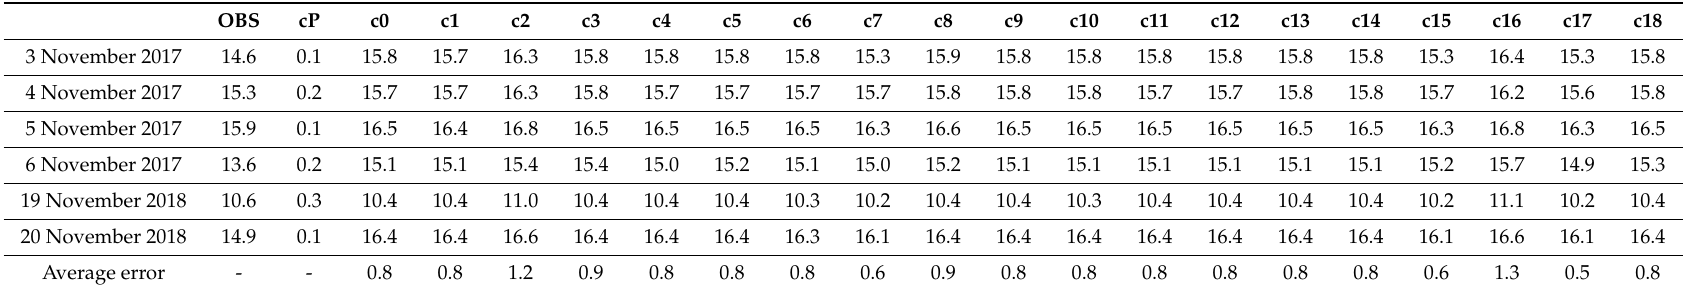
Table 3. Daily mean two-meter temperature (T2m) values ( ◦ C) at the CIRA site for the days considered, for observational and model data (all configurations). Average cumulative errors with respect to observations. Maximum deviation (cP) from the reference simulation with the initial condition ensemble.